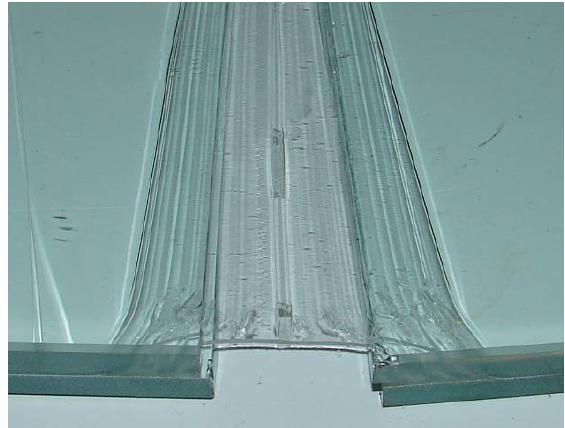
Figure 5: Detail of a particular final delamination pattern of a sample tested at 45°C